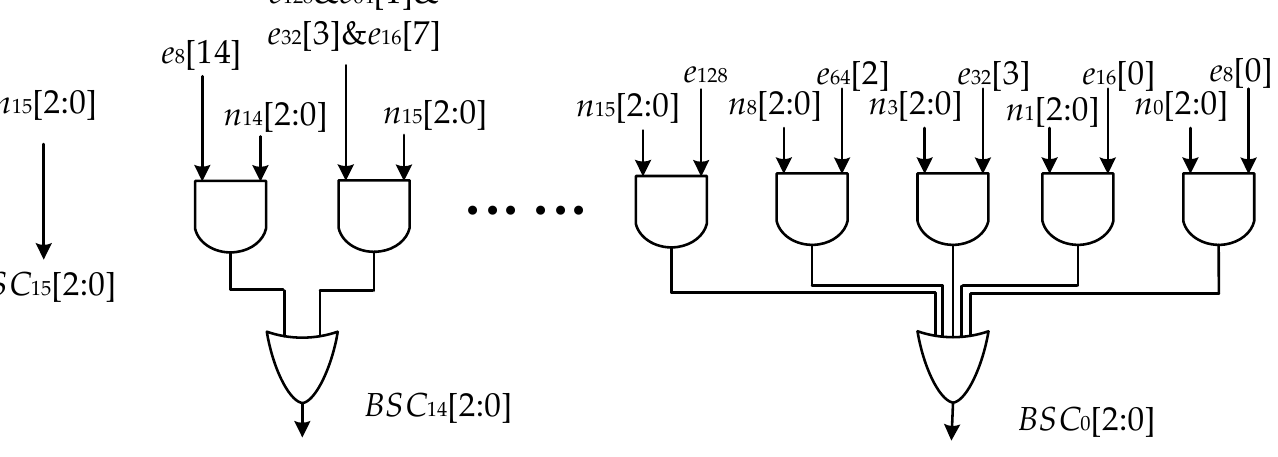
Figure 7. Part of the circuit structure for generating BWC .